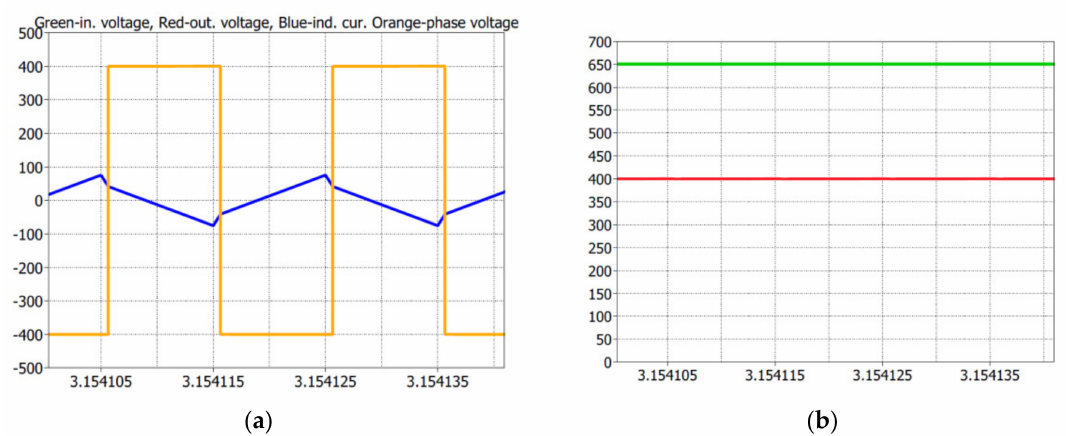
Figure 8. Simulation result—operation of the DC/DC converter during steady state: ( a ) phase voltage (orange) and transformer current (blue); ( b ) input voltage (green), output voltage